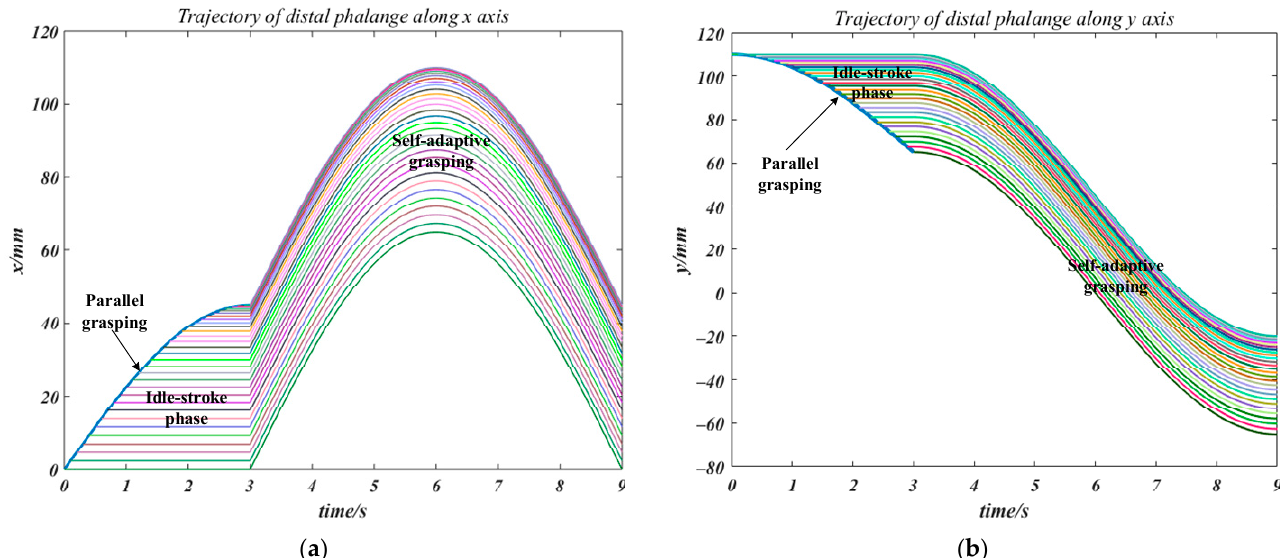
Figure 9. Kinematic analysis of the ESMGM hand (PASA mode): ( a ) Trajectory along the x ‐ axis; ( b ) trajectory along the y ‐ axis.